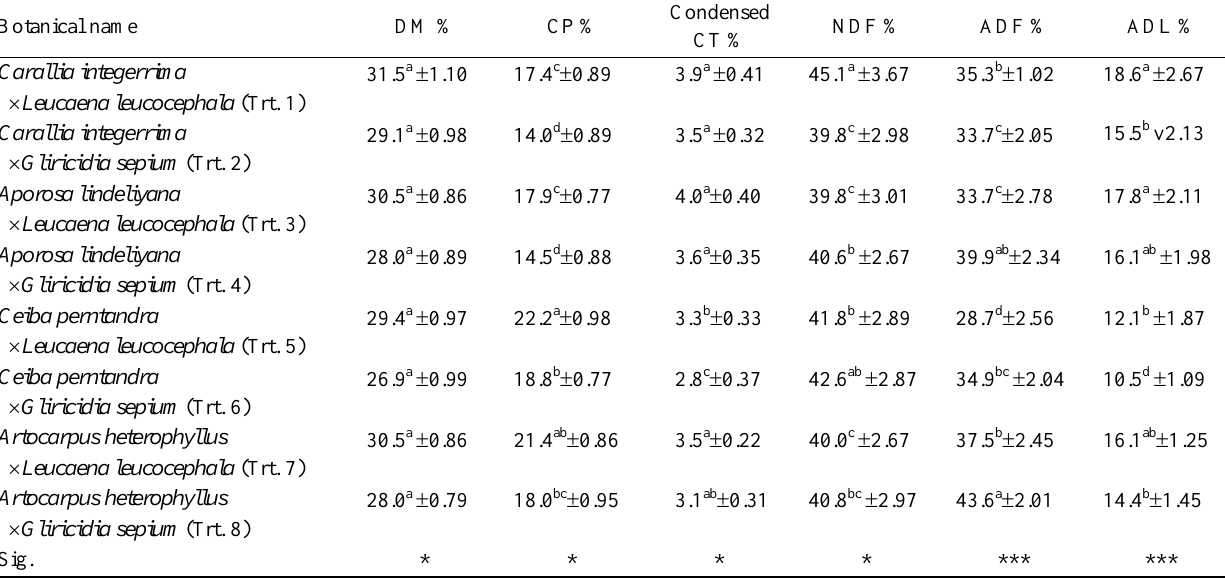
Table 4. Proximate composition of forage mixtures Botanical